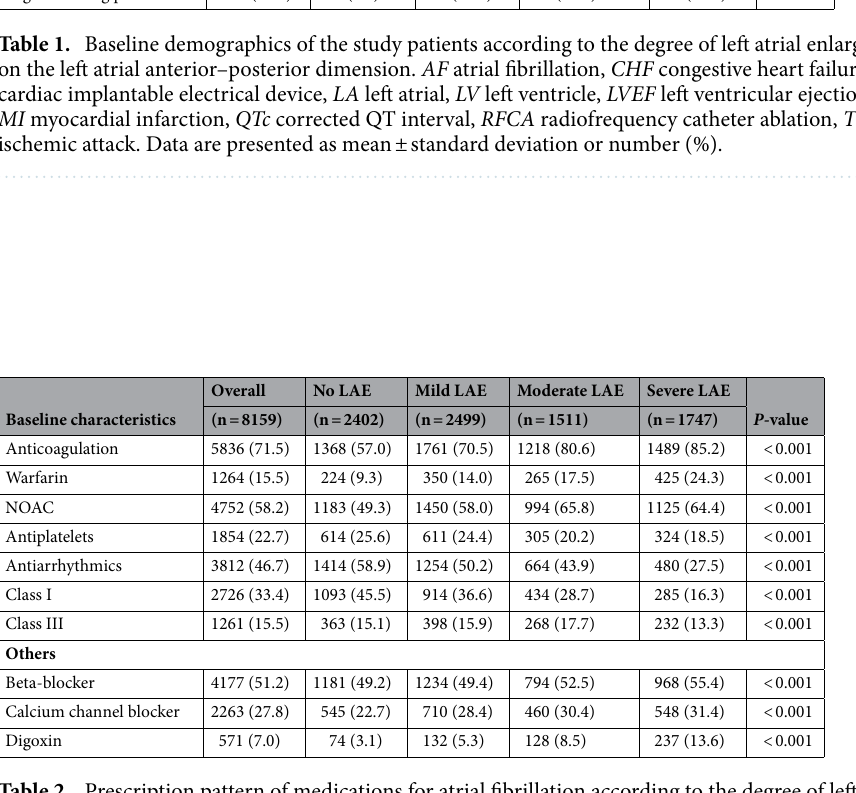
Table 2. Prescription pattern of medications for atrial fibrillation according to the degree of left atrial enlargement by left atrial anterior–posterior dimension. NOAC non-vitamin K antagonist